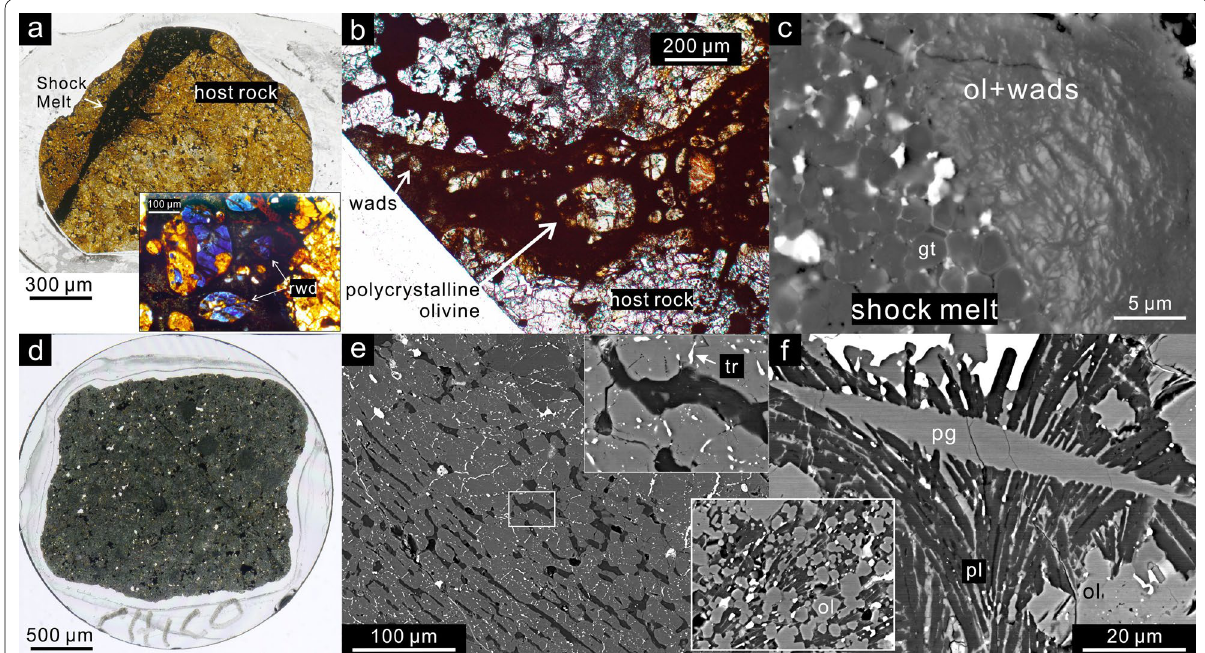
Fig. 8 Variable shock features in L chondrites previously classified as shock stage S5-6. a RC 106 (L6) thin section with a thick shock melt vein. The insert is a plane-polarized light (PPL) micrograph of the shock melt vein containing blue ringwoodite (rwd). b PPL micrograph of a shock melt vein in Mbale (L5-6). The clasts in the thin part of vein are wadsleyite (wads) aggregates and the thicker vein contains polycrystalline olivine. c backscattered electron (BSE) image of a polycrystalline olivine (ol) aggregate with trace wadsleyite in contact with majorite garnet (gt) in quenched Mbale shock melt. d Shock-darkened impact melt breccia Chico (L6). e BSE image of a barred olivine chondrule in melt breccia NWA 091 (L6). The troilite (tr) veinlets are disseminated in the olivine. f BSE image of recrystallized sodic pigeonite (pg)-plagioclase (pl)-olivine (ol) aggregate in Chico. The insert is another recrystallized olivine-plagioclase aggregate. Figures modified after Sharp et al. (2015), Hu (2016) and Hu and Sharp